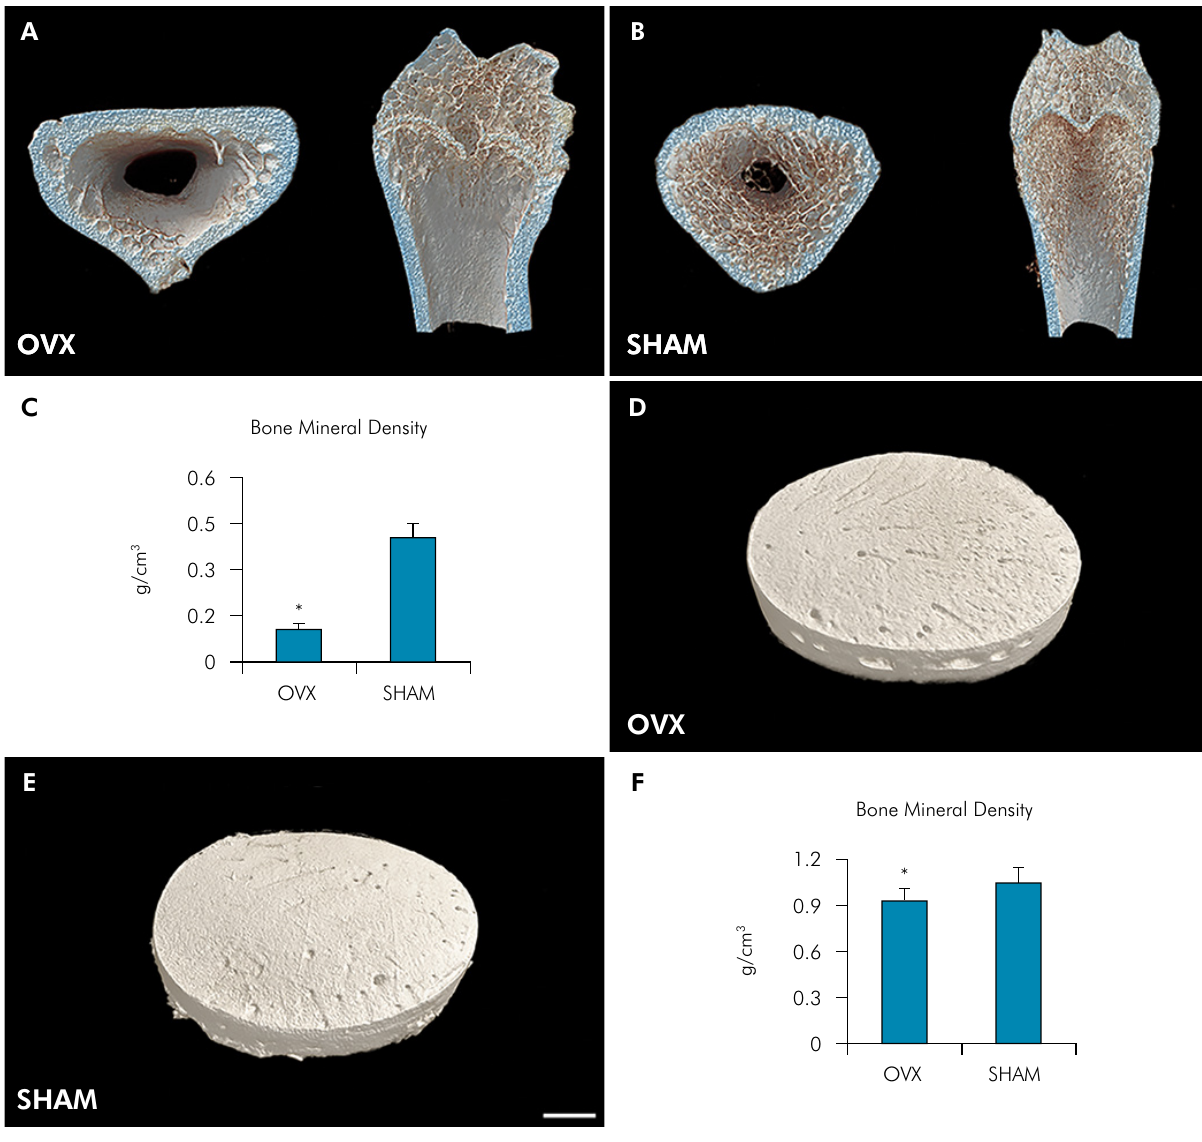
Figure 1. Three-dimensional reconstructed microtomographic images and bone mineral density of femurs and calvarial fragments from osteoporotic (OVX) and normal (SHAM) rats, 5 months post-ovariectomy or sham surgery. The OVX femurs (A) exhibited a reduced trabecular density compared with SHAM (B), in addition to a reduced bone mineral density (C). The calvarial fragments showed a similar bone morphology by comparing OVX (D) and SHAM (E) with OVX displaying a lower bone mineral density than SHAM (F). Data (C, n = 4, and F, n = 5) are presented as mean ± standard deviation. Asterisks indicate statistically significant difference (p ≤ 0.05). Scale bar: A–B = 2 mm and D–E = 8